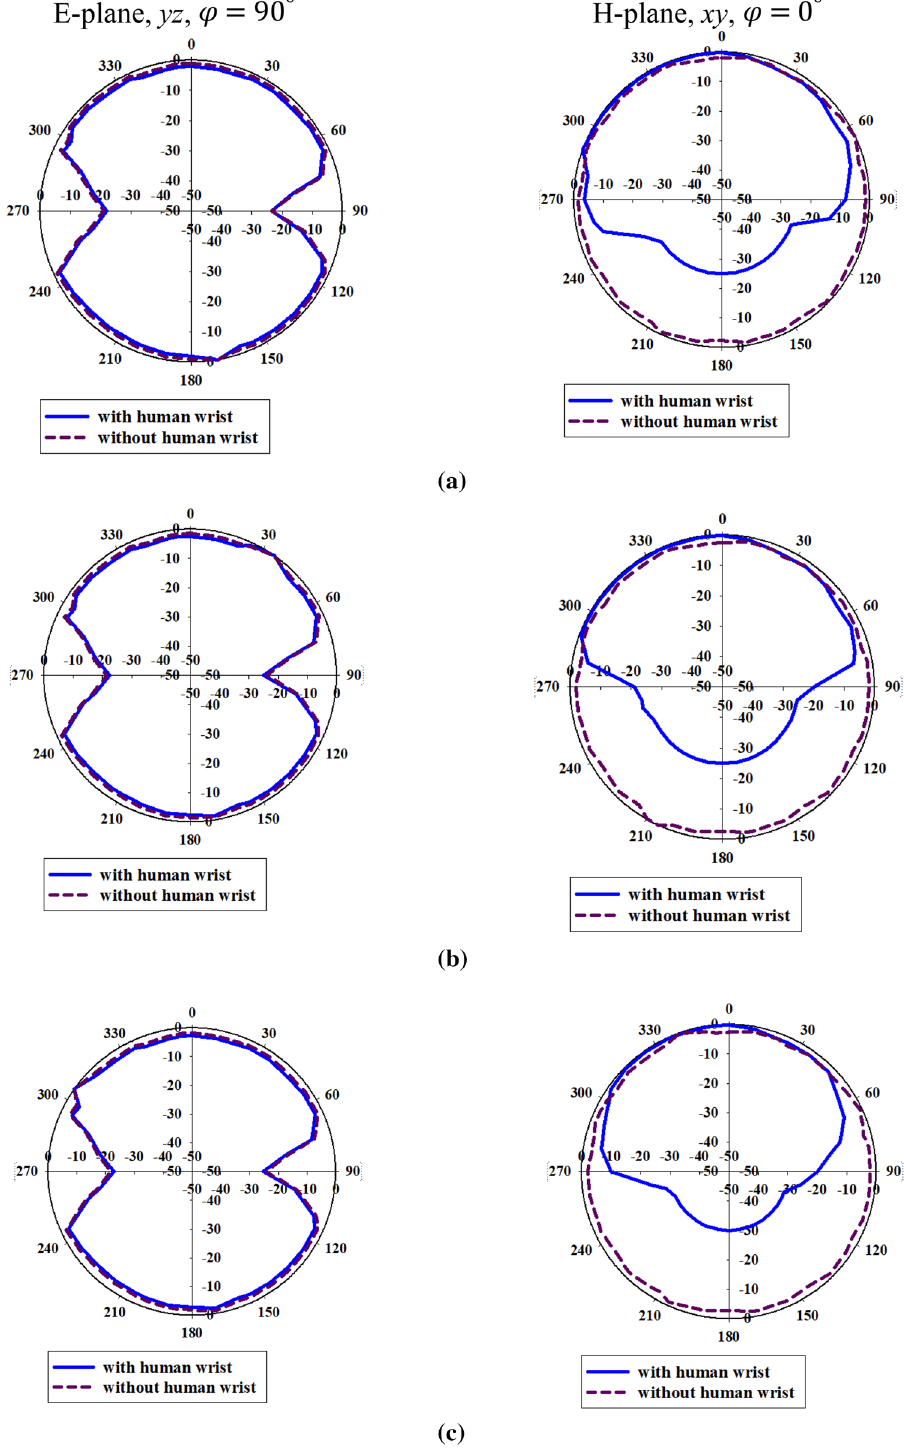
Figure 14. Radiation patterns of the proposed wristband antenna ( a ) 3 GHz, ( b ) 6 GHz and ( c ) 10